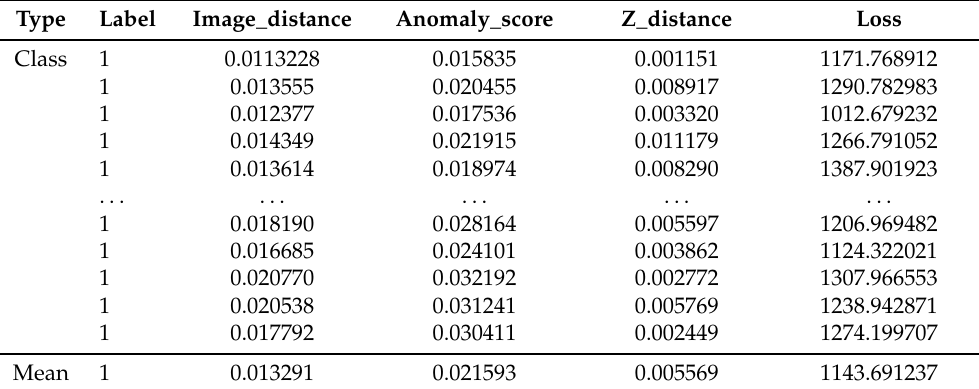
Table 1. Performance matrix of anomaly detection score for normal data.